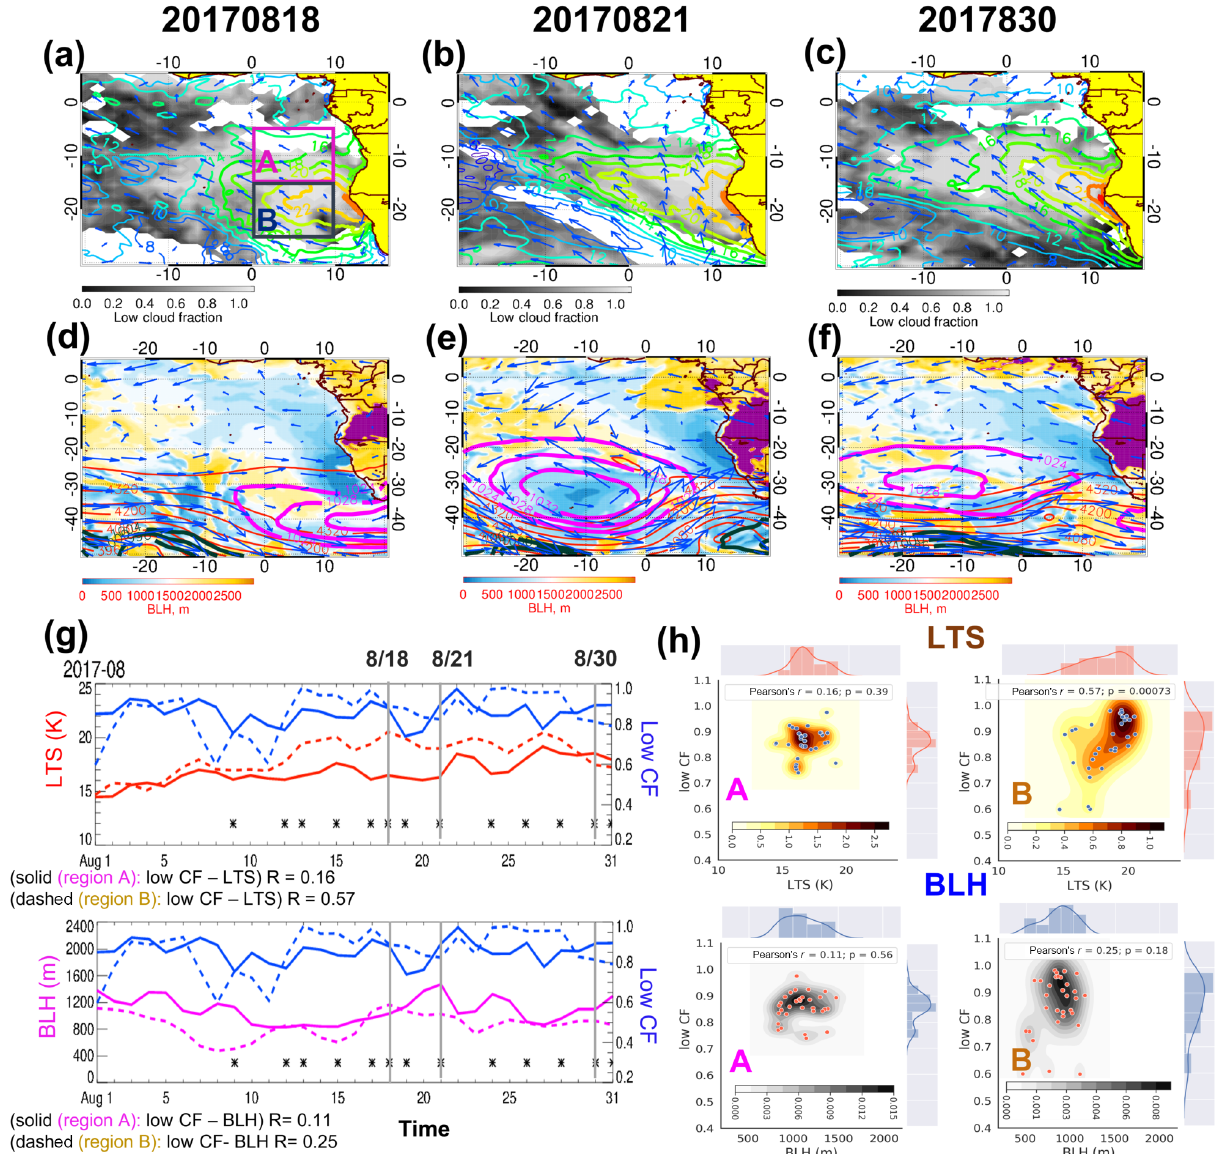
Figure 11. Map of (a–c) daily mean low CF (shading) overlaid by LTS (contour; K) and 925hPa horizontal winds (vectors; ms − 1 ), (d– f) BLH (shading; m) overlaid by 600hPa horizontal winds (vectors; ms − 1 ), 600hPa geopotential height (red lines; m), and sea level pressure (SLP; in lines dark green for low pressure at 996, 1000, and 1004 and magenta for high pressure at 1024, 1028, and 1032; hPa) at 12:00UTC on 18, 21, and 30 August 2017. (g) The top plot shows the time series of daily mean low CF (blue lines) and daily mean LTS (red lines; K), and the bottom plot shows the daily mean low CF (blue lines) and daily mean BLH (magenta lines; m) averaged over region A at 0–10 ◦ E, 5–15 ◦ S (solid lines) and region B at 0–10 ◦ E, 15–25 ◦ S (dashed lines) during August 2017. All flight days (18, 21, and 30 August 2017) are marked by an asterisk (gray vertical lines). The purple shading over land in panels (d) – (f) refers to BLH higher than 3250m. (h) The 2-D joint pdf (shading) with a scatterplot are shown with 1-D histogram (pdf in line) of (top) daily mean low CF and LTS and (bottom) daily mean low CF and BLH over region A (left) and region B (right) during August 2017. The solid line in panel (a) indicates region A (magenta box) and region B (navy box), respectively. The Pearson’s r in panel (h) refers to Pearson correlation coefficient with its statistical significance ( p